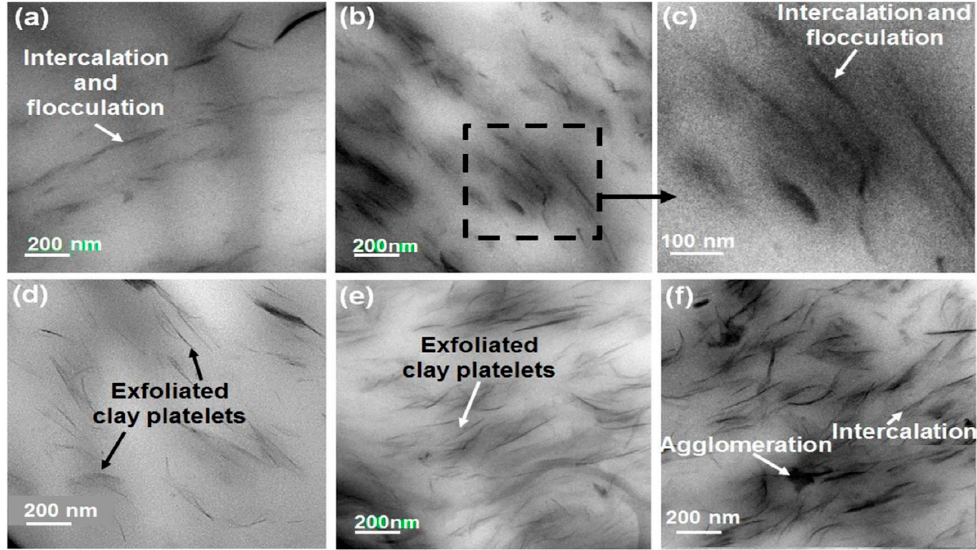
Figure 11. TEM images showing dispersion of clay platelets in CPN: ( a ) PU-CA-1; ( b , c ) PU-CA-3; ( d ) PU-C30B-1; ( e ) PU- C30B-3; ( f ) PU-C30B-5 [55]. ( d ) PU-C30B-1; ( e ) PU-C30B-3; ( f ) PU-C30B-5